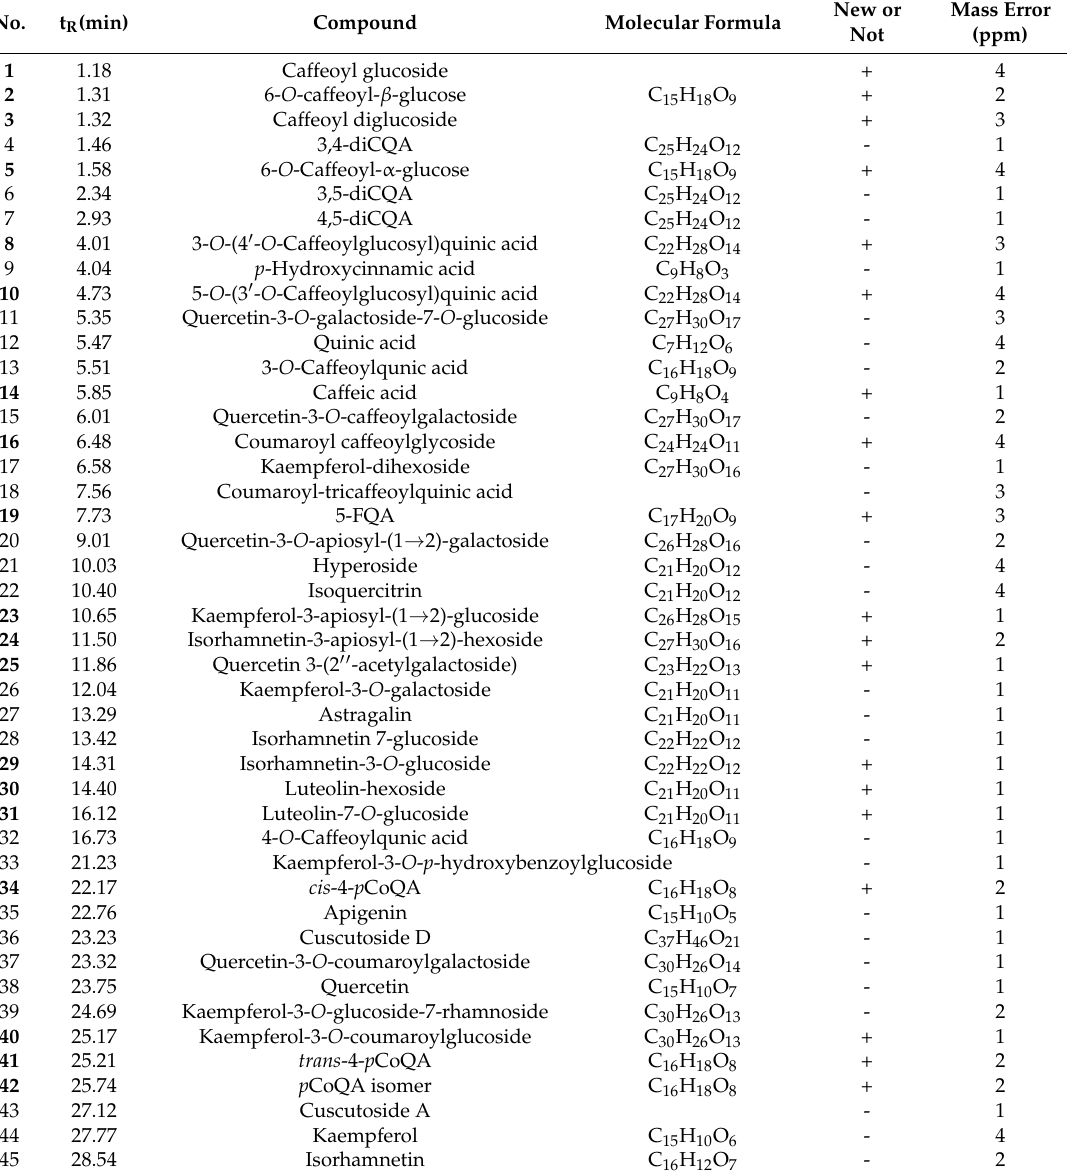
Table 2. The existence of each component in Semen